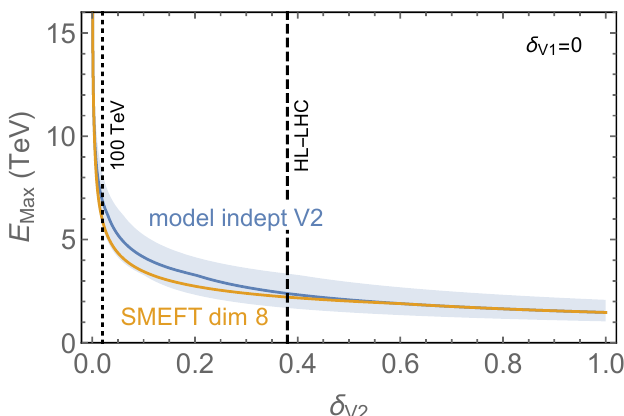
Figure 13 . The unitarity bound from as a function of δ V 2 neglecting small terms proportional to δ V 1 . The optimal bound lies between the model-independent and SMEFT estimates. The band around the model-independent bound results from varying the unitarity bound to 1 For comparison, we show 95% C.L. limits on the coupling from the vector boson fusion di-Higgs analysis projected for the HL-LHC and a 100 TeV pp collider